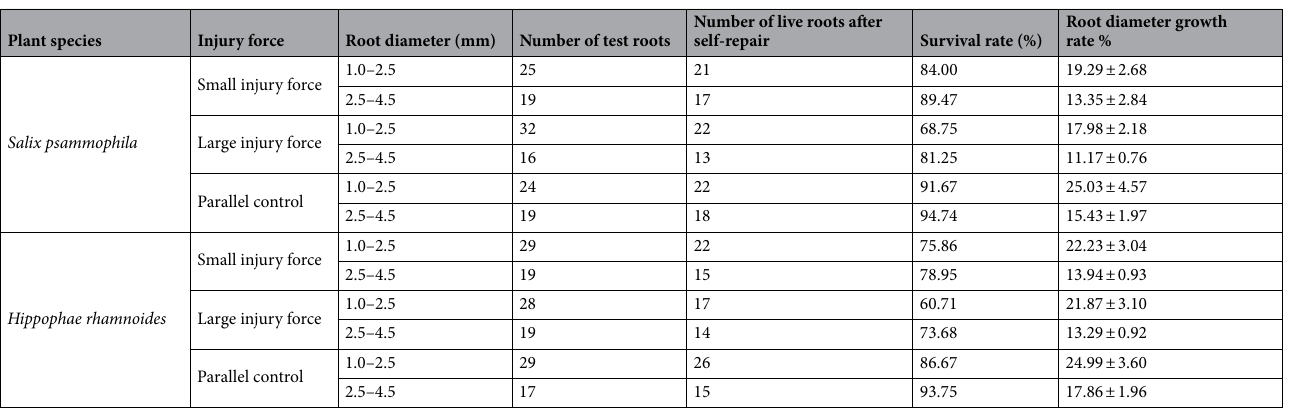
Table 3. Survival rate and root diameter growth rate of 2 plants after